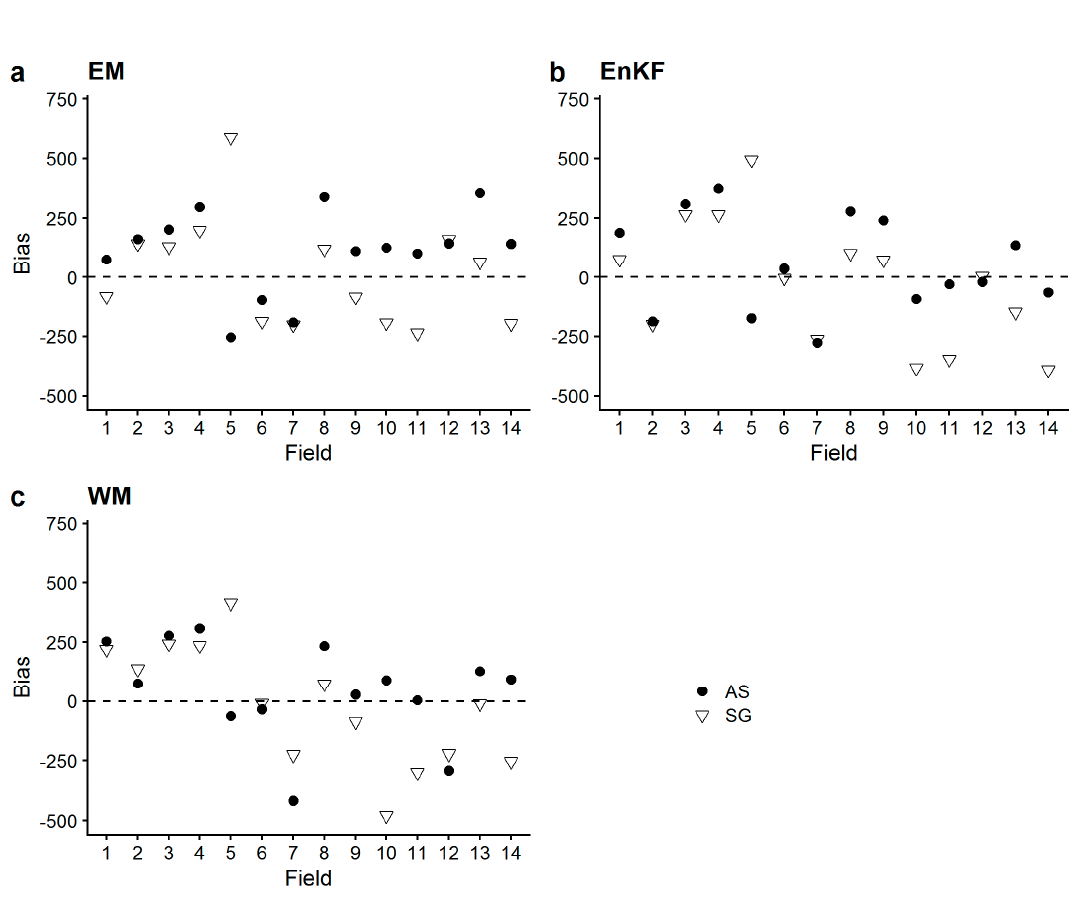
Figure 8. Bias calculated from measured vs. predicted biomass in all sampling points per field, for analyzed soil texture (AS) as model input and SoilGrids-extracted (SG) soil texture as model input. ( a ) Results for ensemble mean (EM); ( b ) results for ensemble Kalman filter (EnKF); ( c ) results for weighted mean (WM). All values in g m − 2 . Positive values indicate overestimation of measured biomass by the model.